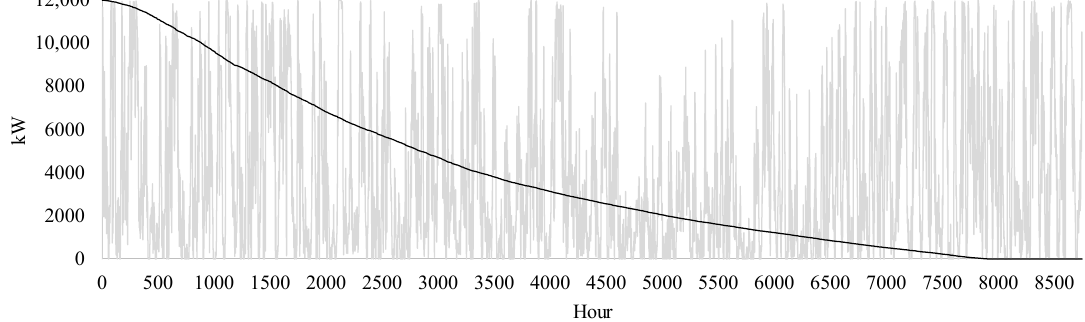
Figure 3. Summerside 2017 hourly wind generation and power duration curve.